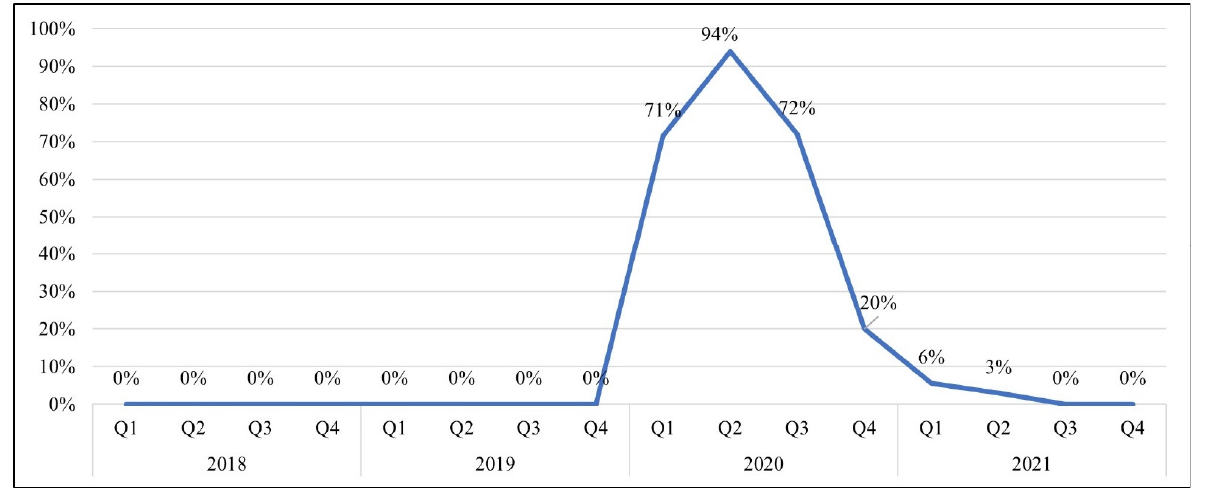
Figure 3. Percentage of Print Magazine Ad Occurrences for Black & Mild Featuring Voluntary Warning Labels.